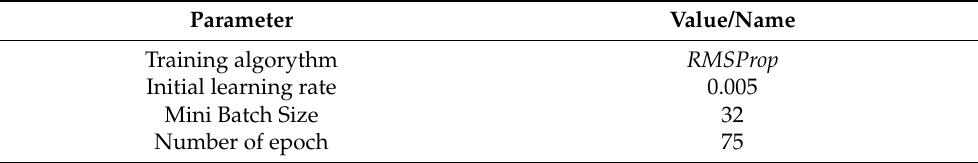
Table 6. Selected training process